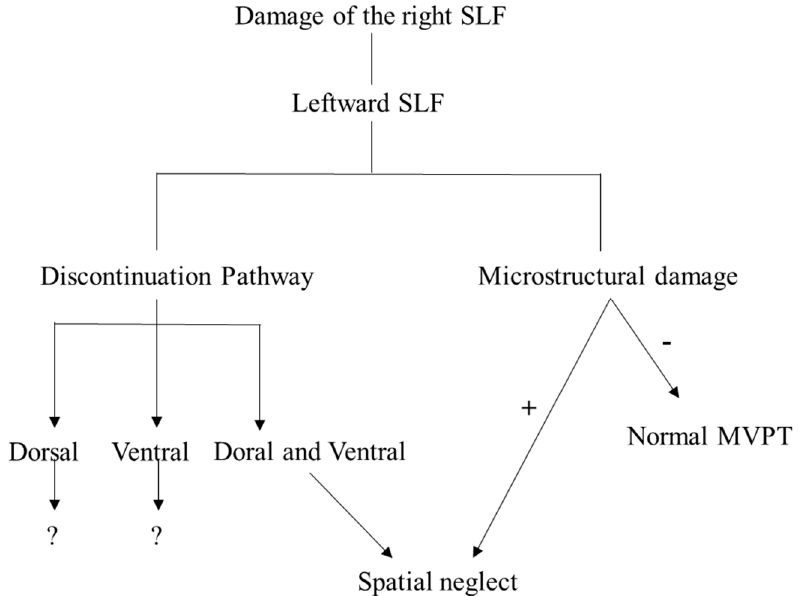
Figure 4. Summary of the pathway based on our finding. Note: SLF, superior longitudinal fasciculus. “?” means the requirement of further study. + ; the right SLF with microstructural damage, − ; the right SLF without microstructural damage.